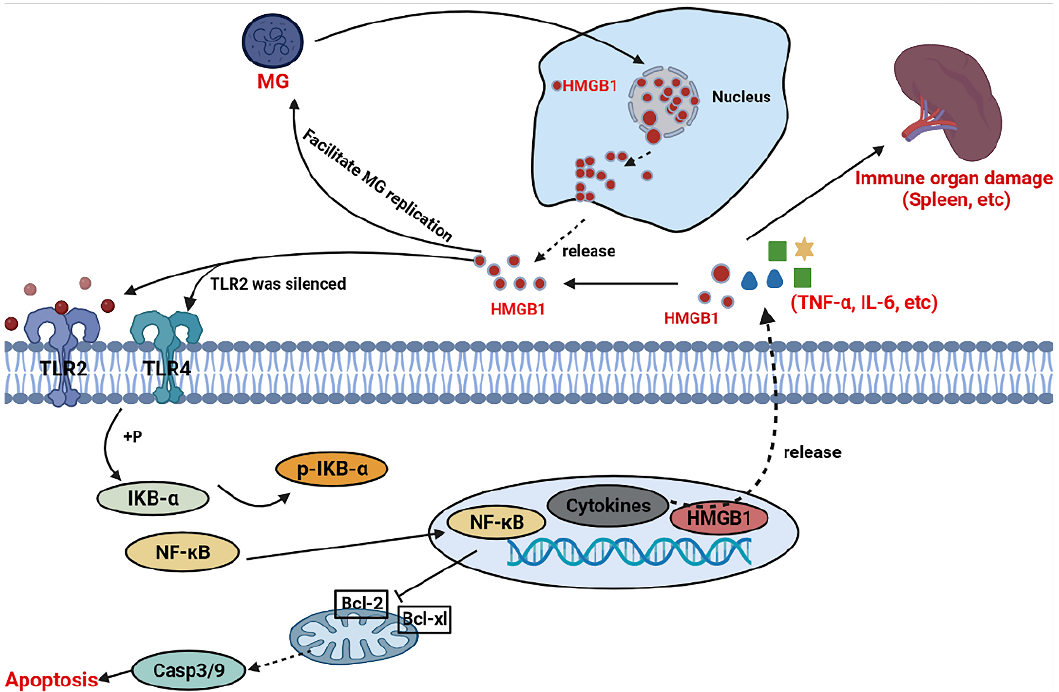
Figure 8. Schematic diagram. MG invasion of immune cells (such as chicken macrophages, HD-11) increases the level of inflammatory mediators (such as HMGB1) in the extracellular environment and, thus, worsens the progression of infection. In vivo, enrichment of inflammatory mediators in immune organs (e.g., spleen) aggravates their inflammatory damage.